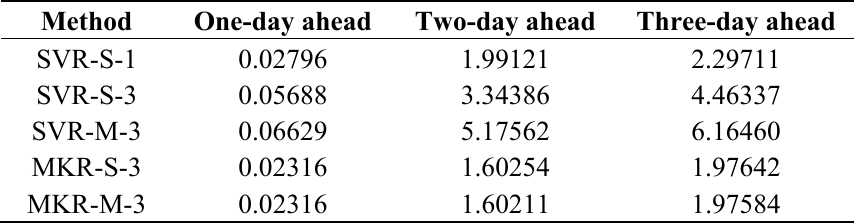
Table 3. Average RMSE/mean results for Brent Crude oil price prediction (total 14 experiments).